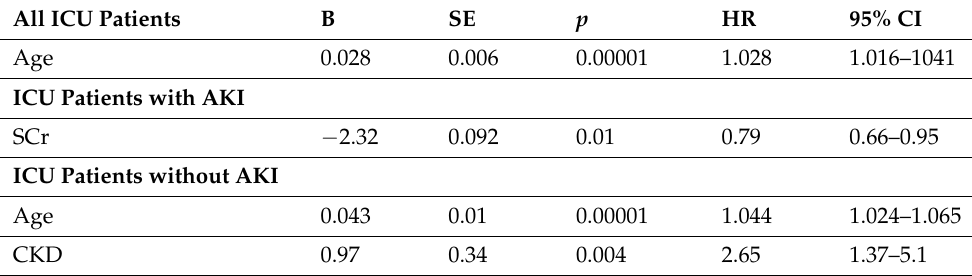
Table 12. Multivariate Cox proportional hazards analysis of risk factors for mortality. All ICU Patients